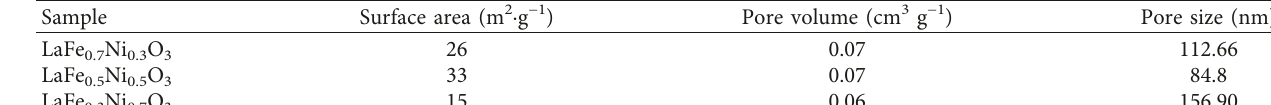
Table 2: Textural properties of the catalysts after reduction at 600 ° C.